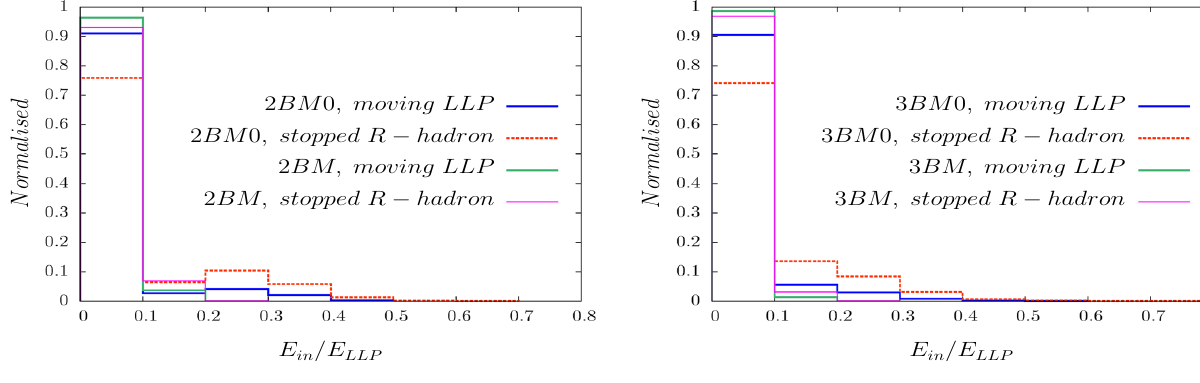
Fig. 15 As in Fig. 14 but for the case of the muon chamber Table 7 Lifetime estimates by model-dependent χ 2 fitting of the d T distribution for the displaced leptons